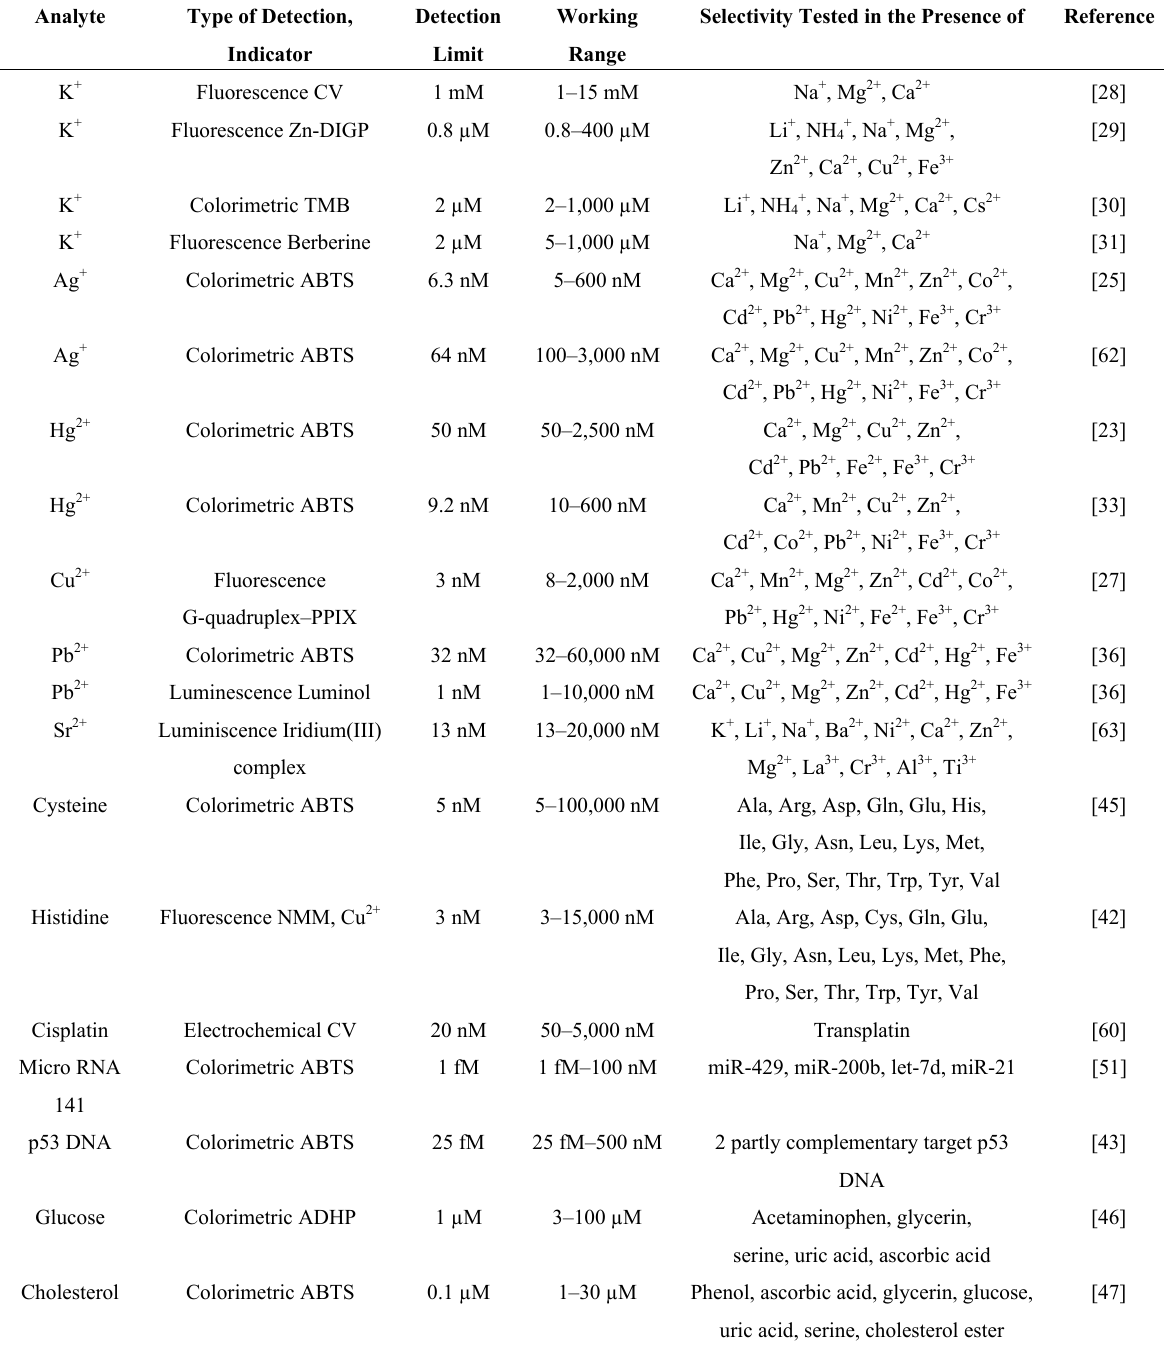
Table 1. Overview of some performance parameters (sensitivity, working range, selectivity) of G-quadruplex based detection